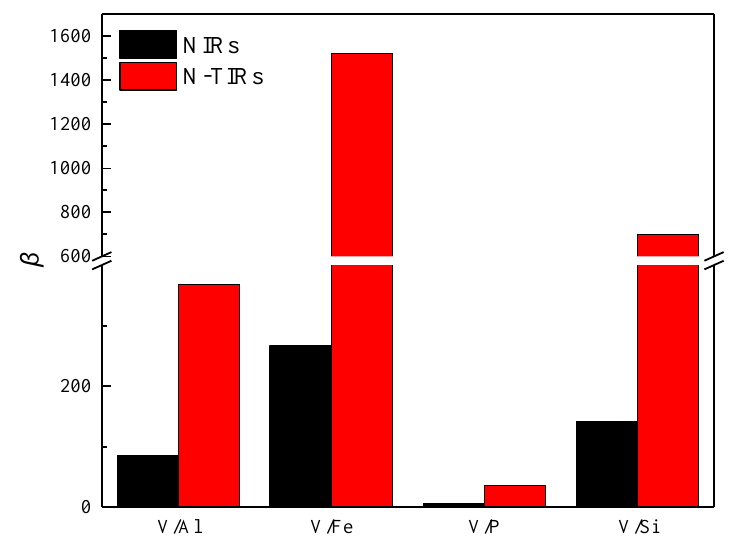
Figure 11. The separation factor for V(V) over impurities onto N-TIRs and NIRs.